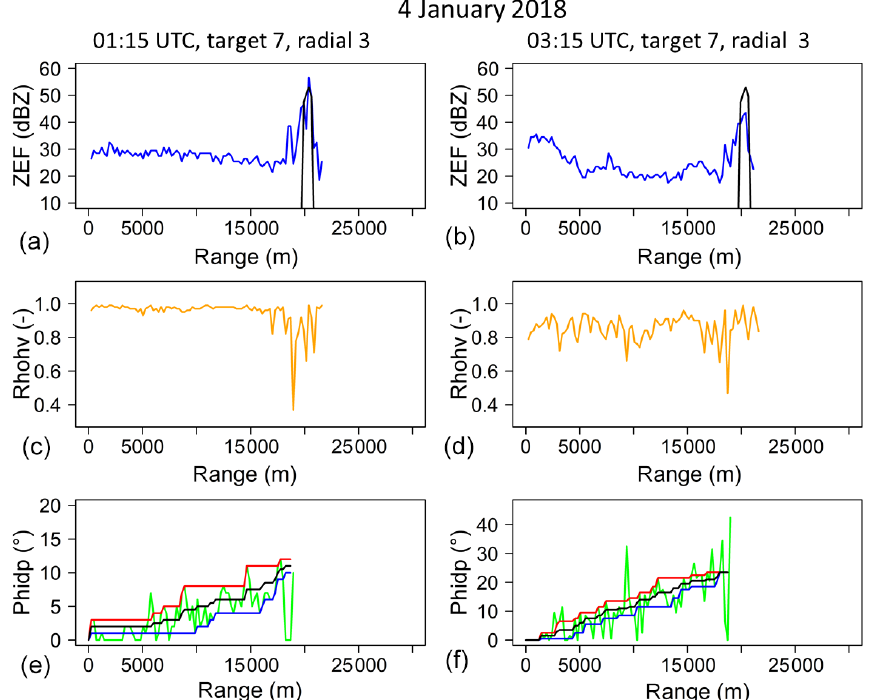
Figure 7. Two examples (a, b) of Z h , ρ hv , and φ dp range profiles of the MOUC radar (0 ◦ PPI) during the 21 July 2017 convective event for one radial of a given mountain target. The raw horizontal reflectivity profiles (a, b) at the considered time steps (blue) are displayed together with the dry weather reference target value (black). The ρ hv profiles (c, d) are used to detect the rainy gates not affected by clutter at close range and in the region of the mountain target. Panels (e) and (f) display the raw ψ dp profiles (green) and the upper (red) and lower (blue) envelope curves and the regularized φ dp profiles